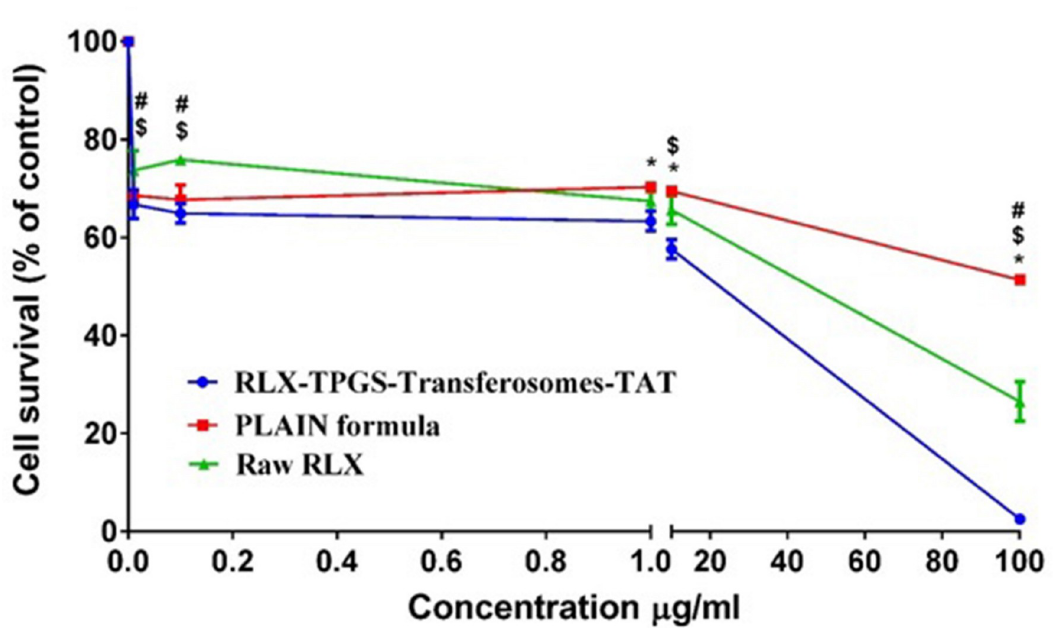
Fig 6. IC 50 % of RLX-TPGS-transferosomes-TAT, plain TPGS-transferosomes-TAT formula and raw RLX. Notes: Value indicate the mean ± SD (n = 6). � p < 0.05 RLX-TPGS-transferosomes-TAT compared to plain TPGS-transferosomes-TAT formula; $ p < 0.05 RLX-TPGS-transferosomes-TAT compared to raw RLX; # p < 0.05 plain TPGS-transferosomes-TAT formula compared to raw RLX.